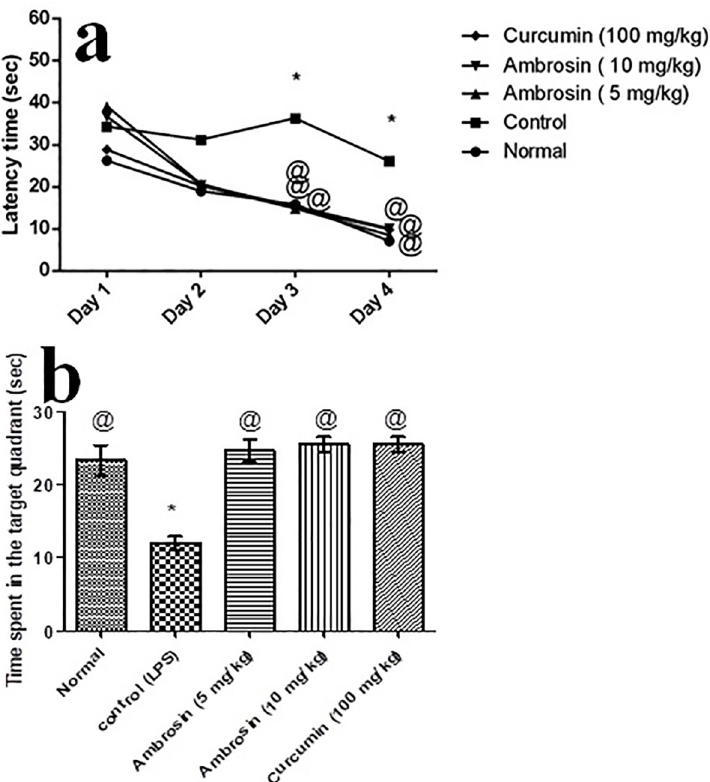
Fig 2. Effect of different treatments on different parameters of MWM. a) Effect on the mean escape latency time. b) Effect on the mean time spent in the target quadrant. Results are expressed as mean ± SEM (n = 8). � Significant difference from normal group at p < 0.05. @ Significant difference from control (LPS) group at p < 0.05.